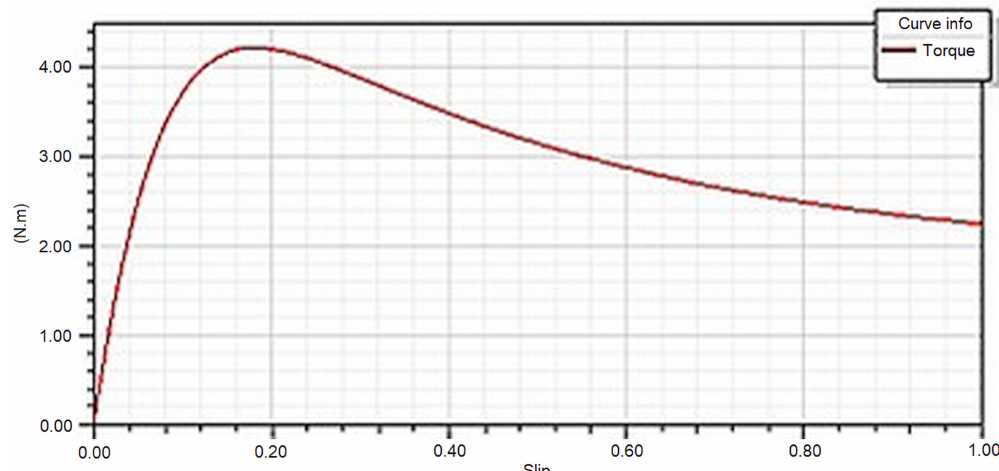
Figure 11. Torque vs Slip project Calculation Result window as a feature.